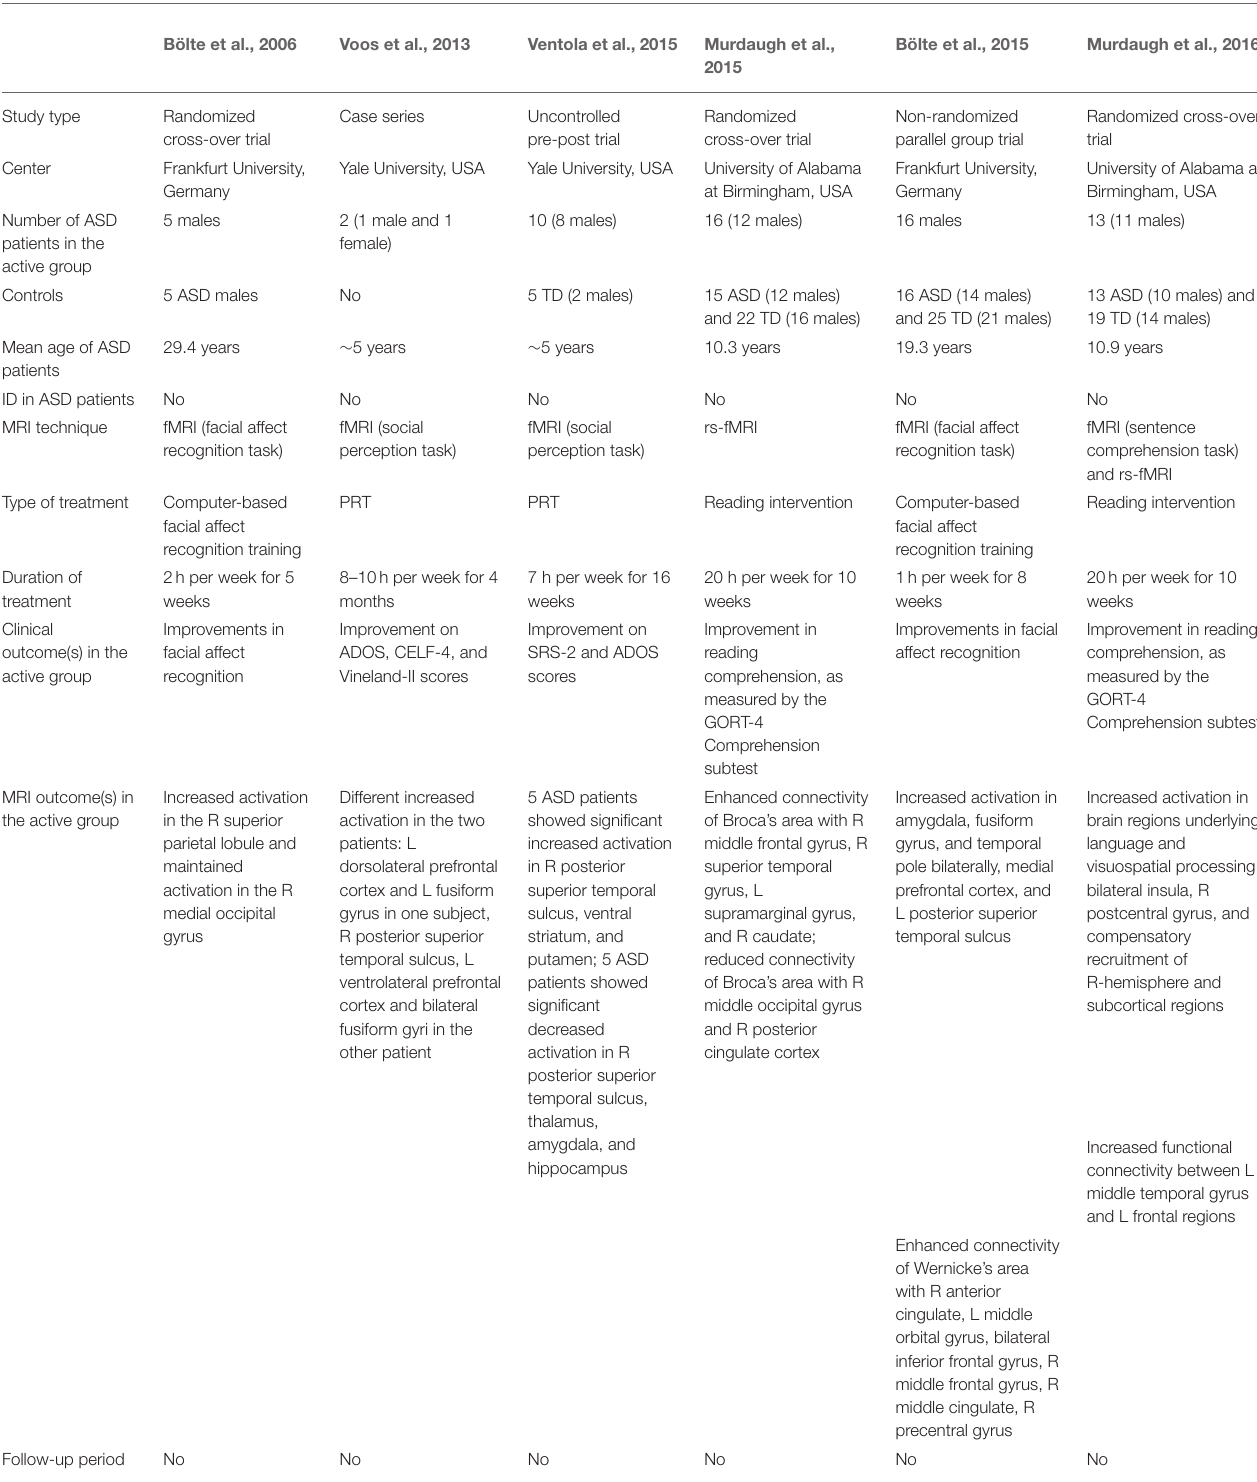
TABLE 1 | Summary of studies utilizing MRI pre- and post-rehabilitative treatment of ASD